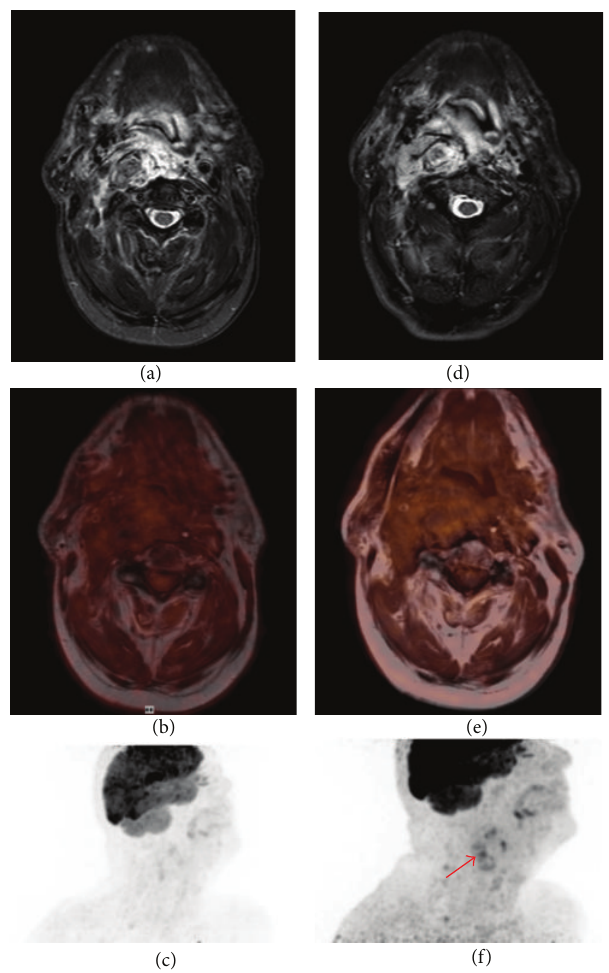
Figure 2: A 68-year-old patient with liposarcoma of the oropharynx. A maximum intensity projection (MIP) of the PET shows increased FDG uptake in the tumour ((f), arrow) as compared to the PET six months before (c). The short tau inversion recovery (STIR) images ((a) and (d)) and the corresponding fused PET/MR images ((d) and (e)) show no change in tumour size over six